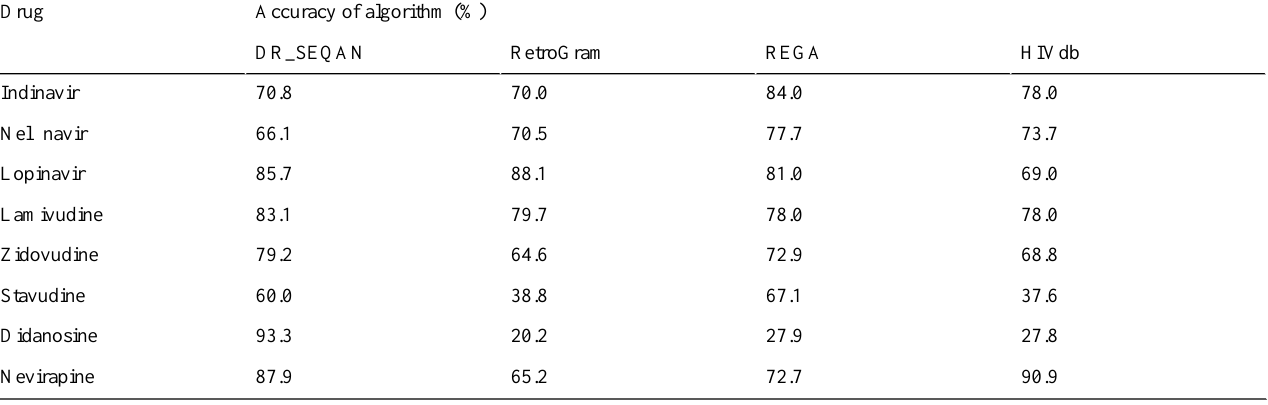
Table 2. Accuracy of predicting ARV drug resistance by the domain-based algorithms, Drug Resistance SEQuence ANalyzer (DR_SEQAN), RetroGram, REGA, and HIVdb